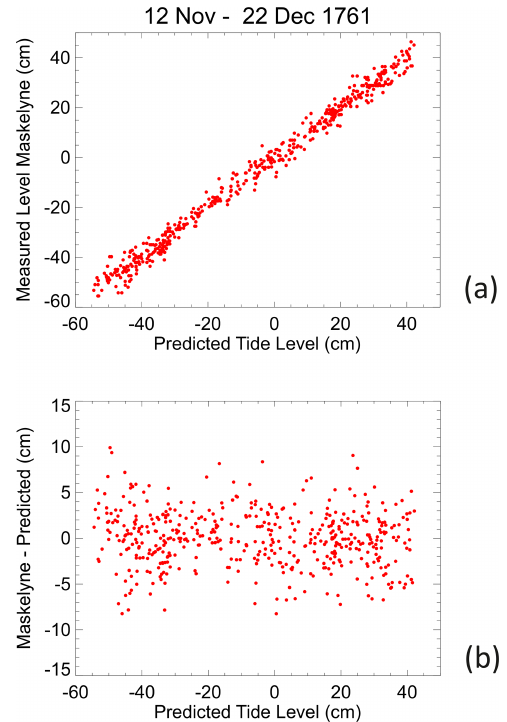
Figure 4. (a) Predicted and Maskelyne sea level values after datum shift adjustment. (b) Sea level differences (Maskelyne − predicted) after datum shift correction showing no major dependence on tidal